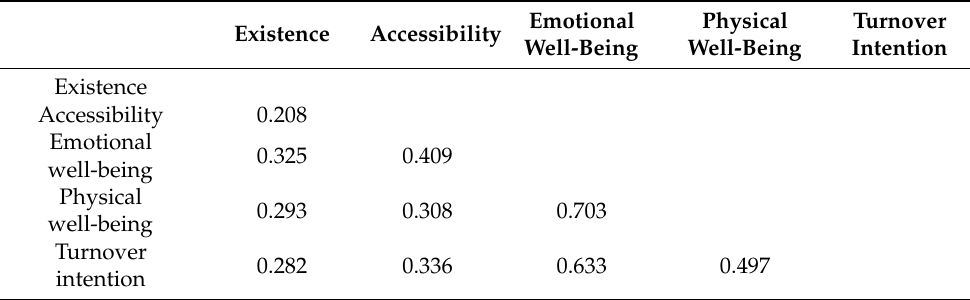
Table 1. Measurement model. Discriminant validity. HTMT ratio (Heterotrait-Monotrait ratio).